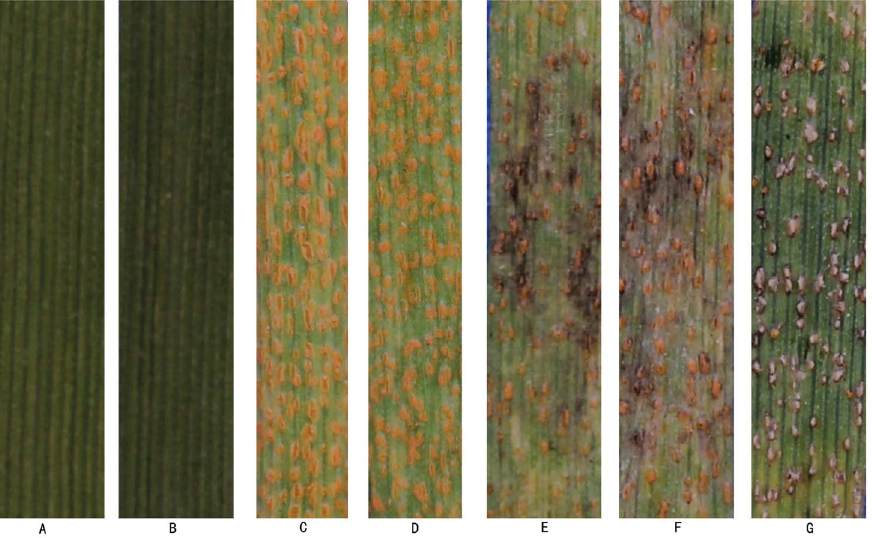
Figure 4. The pathogenicity test to confirm that C.cladosporioides could hyperparasite Pst . A , B : CK1, wheat leaves (Cultivar: MingXian169) inoculated with C. cladosporioides , 14 dpi, without symptoms; C , D : CK2, Symptoms on wheat leaves (MingXian169) inoculated with CYR32, 20 dpi; E , F , G : Pustules on wheat leaves (same cultivar and race as above) inoculated at 14 dpi with C. cladosporioides suspension. Symptoms at 5d, 7d and 9d later.